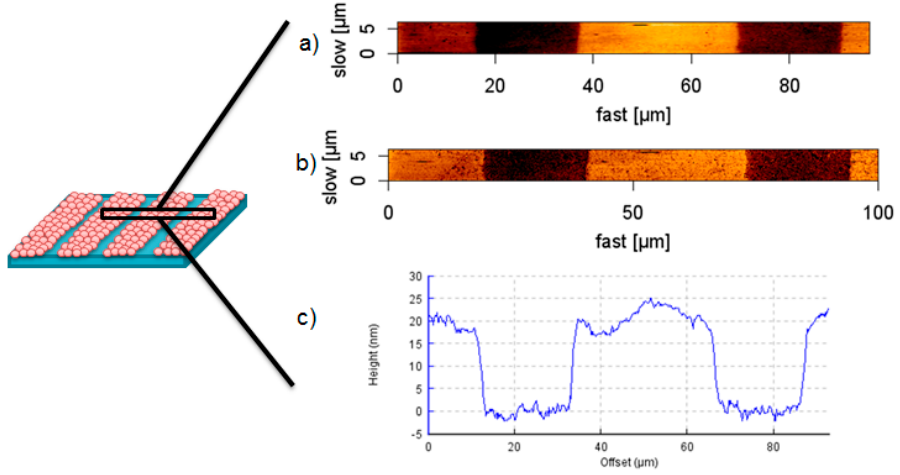
Figure 6. AFM ( a ) height image, ( b ) phase image and ( c ) cross-section profile of an Au NPs (20 nm) patterned PEG-hydrogel after transfer, pattern size (25 µm-25 µm-5 µm).